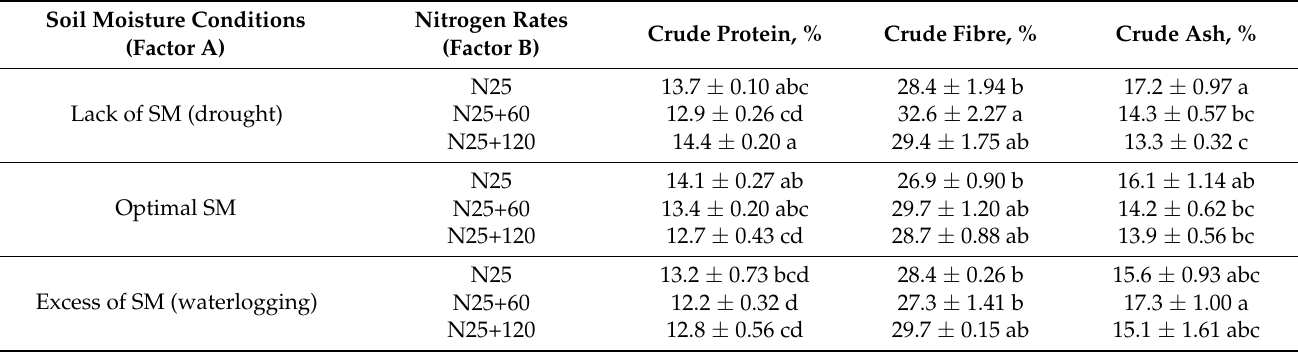
Table 1. Nutritive Value of red clover and forage timothy mixture.